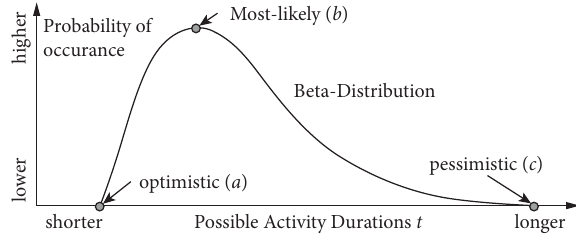
Figure 2: Typical density function of the PERT-beta